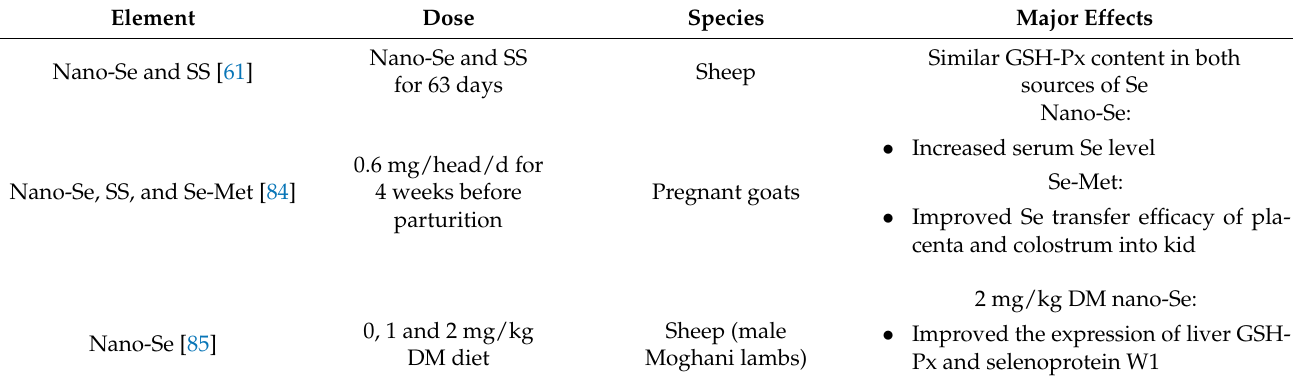
Table 3. Effects of nanominerals on serum antioxidant parameters, immune response and serum/milk composition in